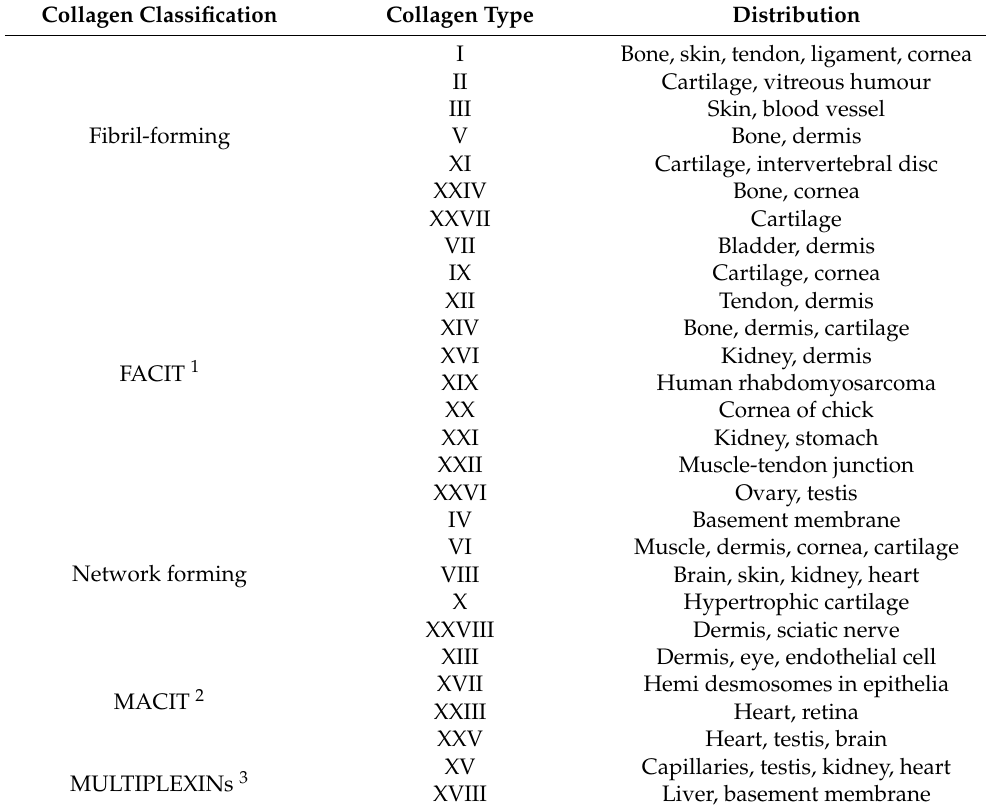
Table 1. Classification of collagen